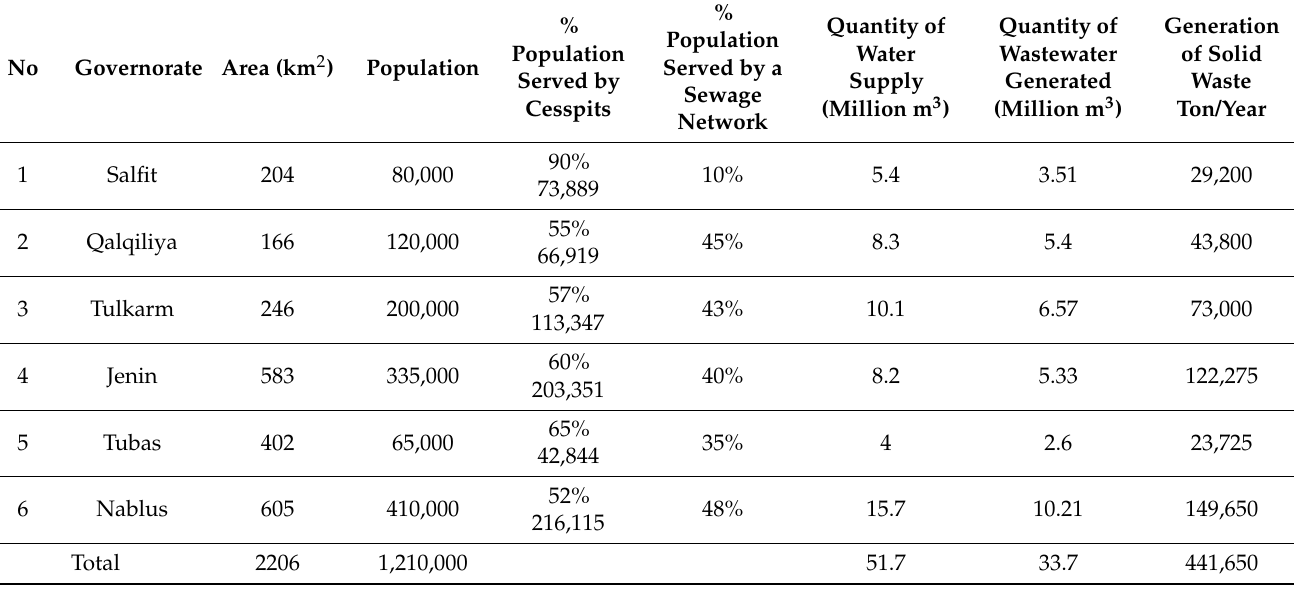
Table 5. Governorate, area, population, wastewater disposal systems, generation of solid